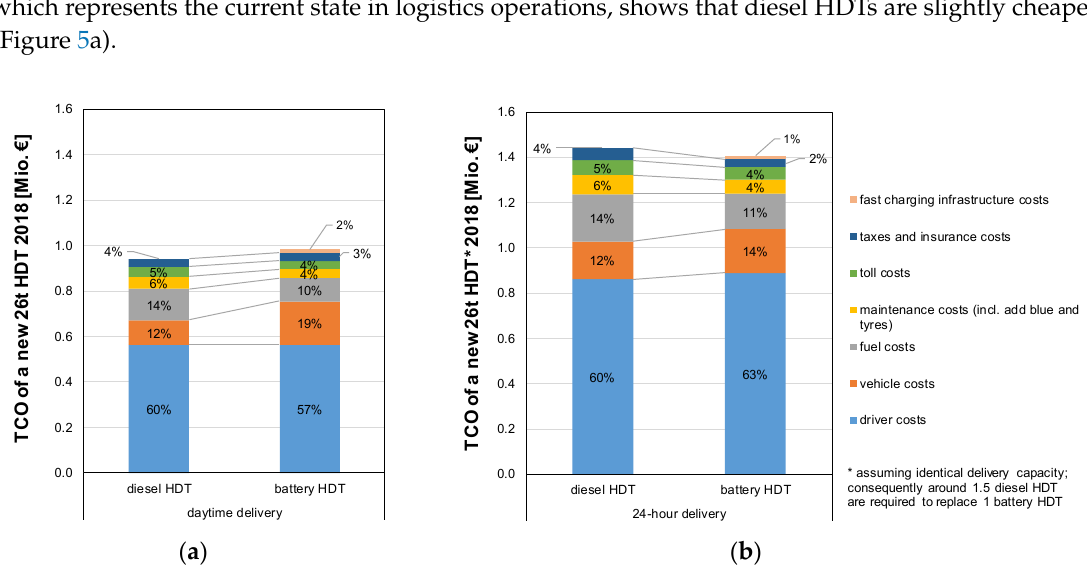
Figure 5. Absolute and relative total cost of ownership (TCO) of a new 26t truck in 2018 for day ( a ) and day and nighttime delivery ( b ).